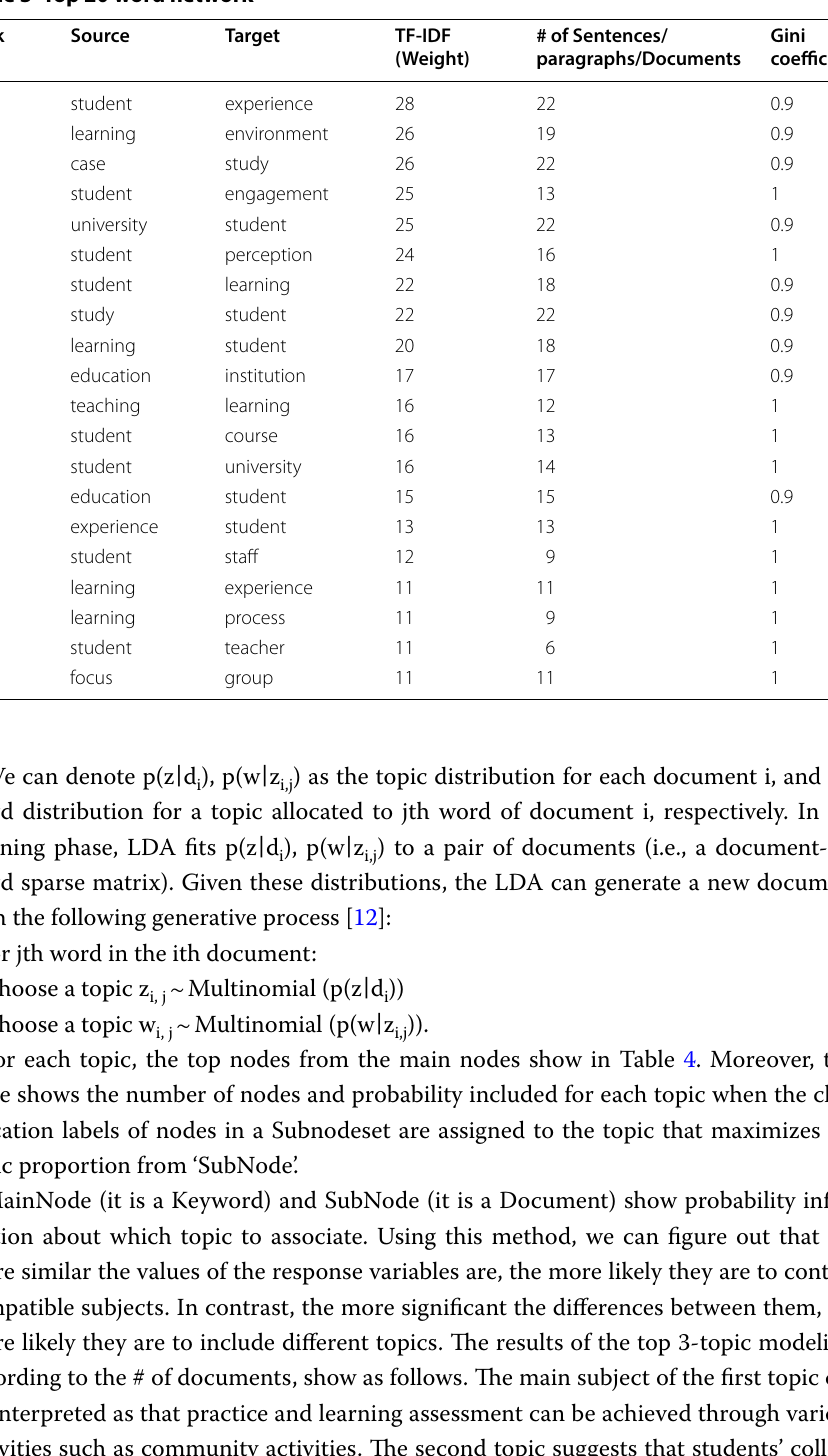
Table 3 Top 20 word